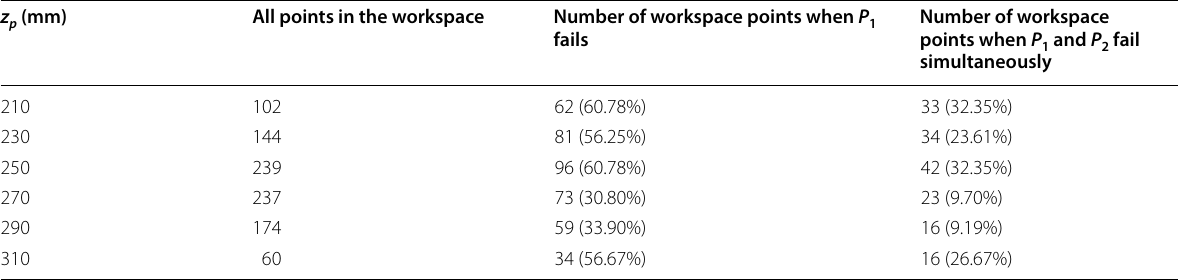
Table 2 Changes in the workspace of the mechanism z p (mm) All points in the workspace